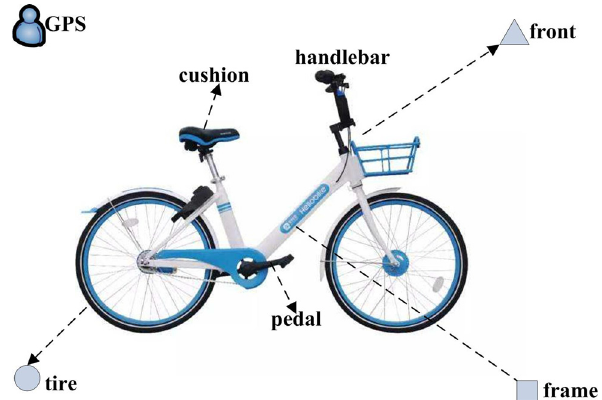
Figure 1: Shared bike con fi